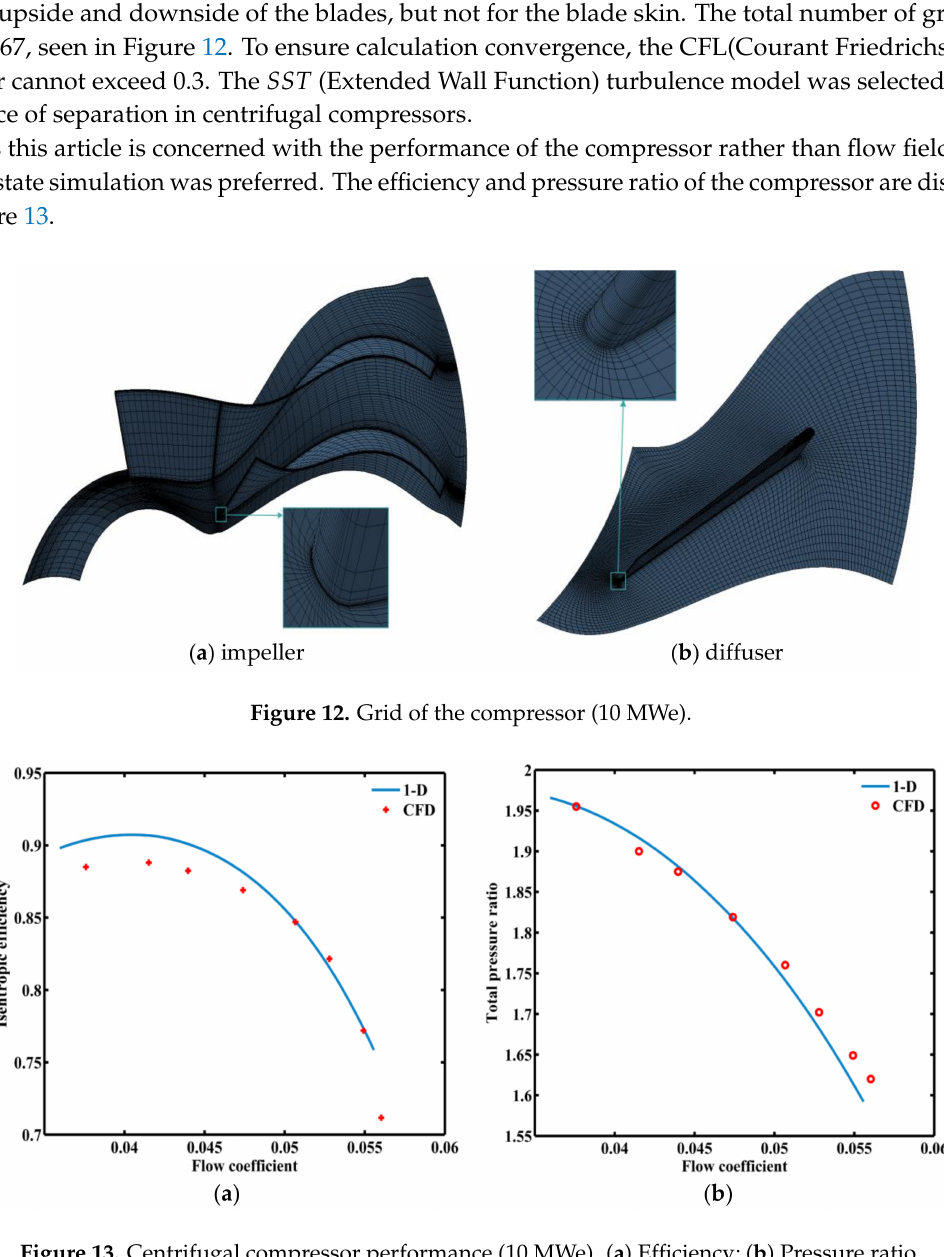
Figure 13. Centrifugal compressor performance (10 MWe). ( a ) Efficiency; ( b ) Pressure ratio.